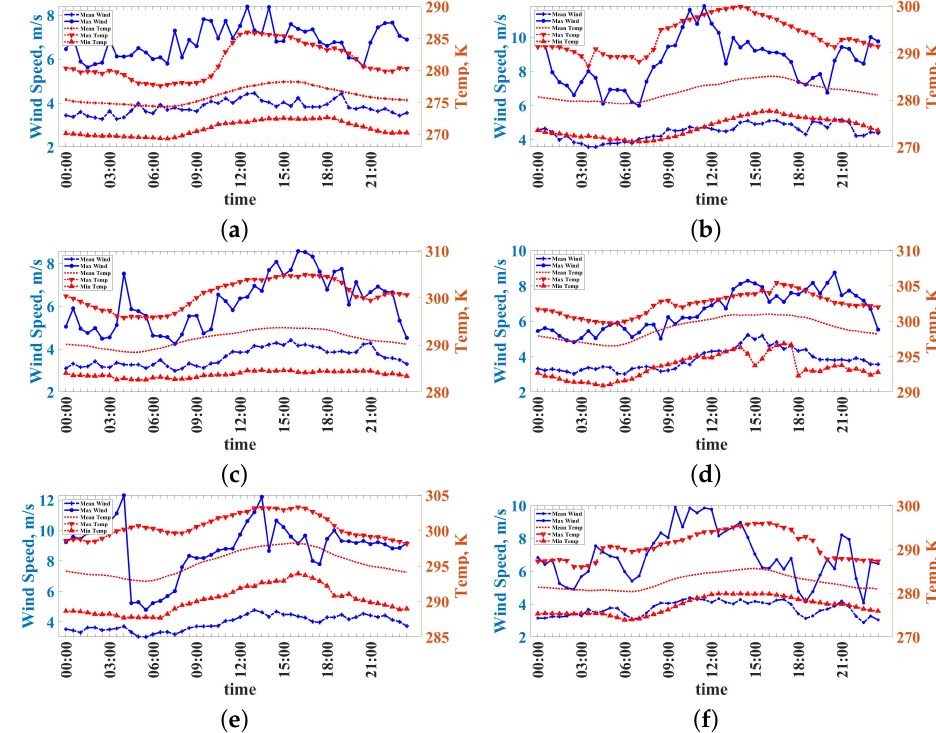
Figure 4. Diurnal temperatures and wind speeds for the odd-numbered months of 2021: ( a ) January, ( b ) March, ( c ) May, ( d ) July, ( e ) September, ( f ) November. The minimum and maximum values are the extreme 30-minute average for that diurnal increment for the